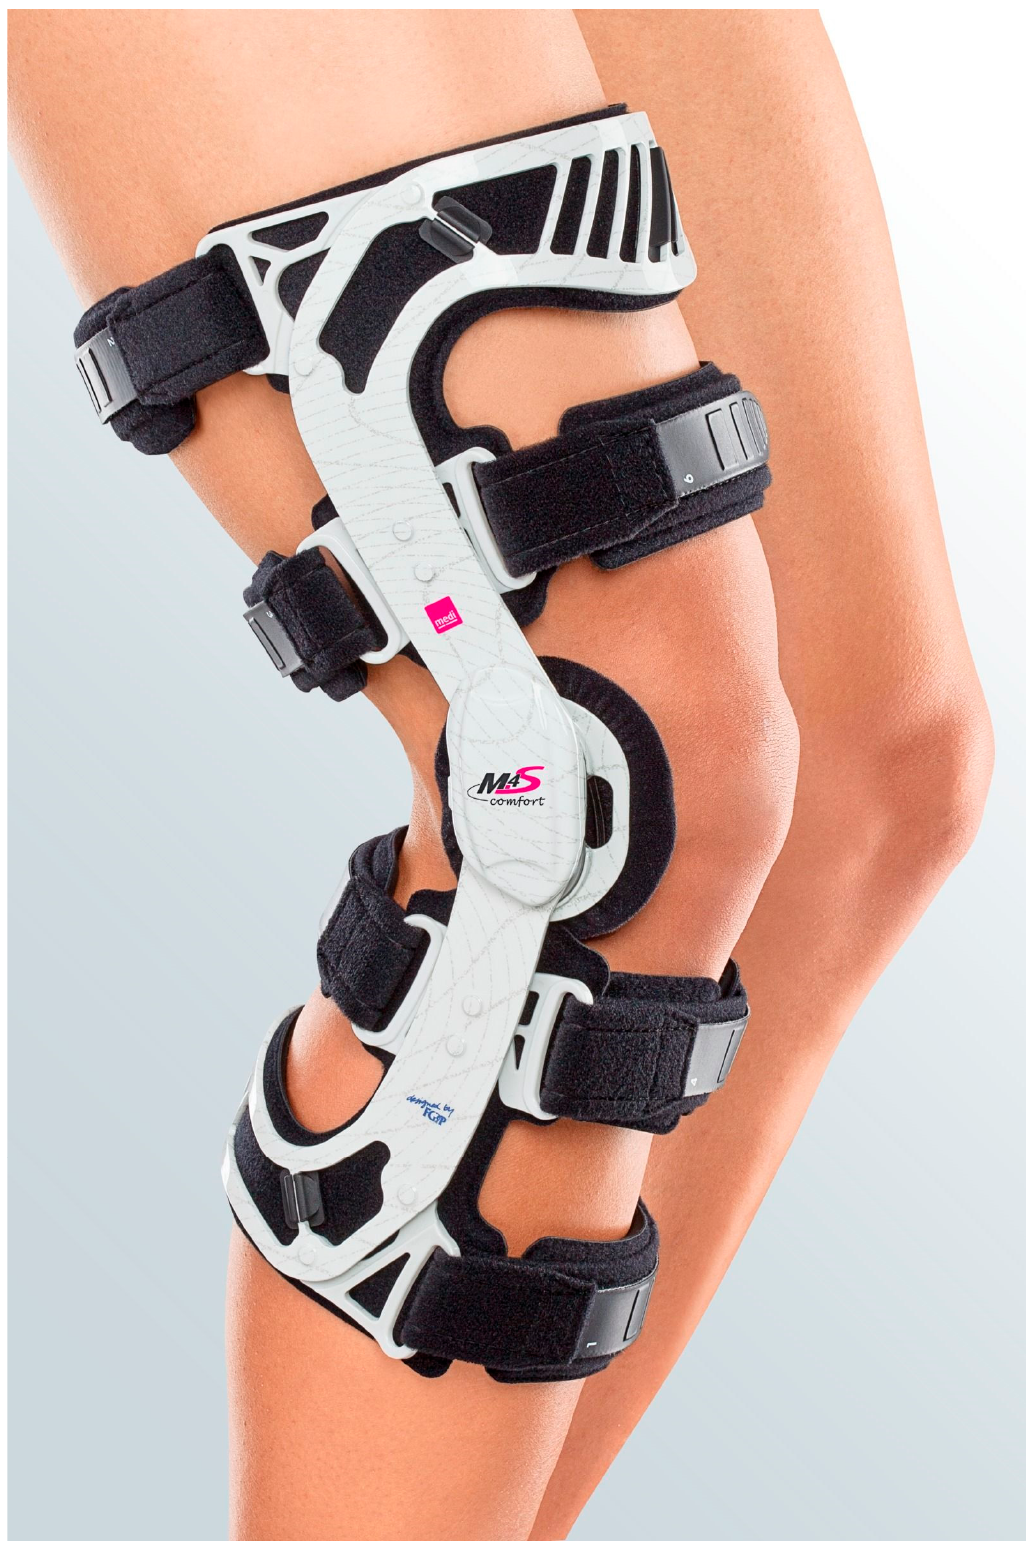
Figure A1. Medi M.4 brace, medi GmbH, Bayreuth, Germany (https://www.medi.de/produkte/m- 4s-comfort/, accessed on 4 January